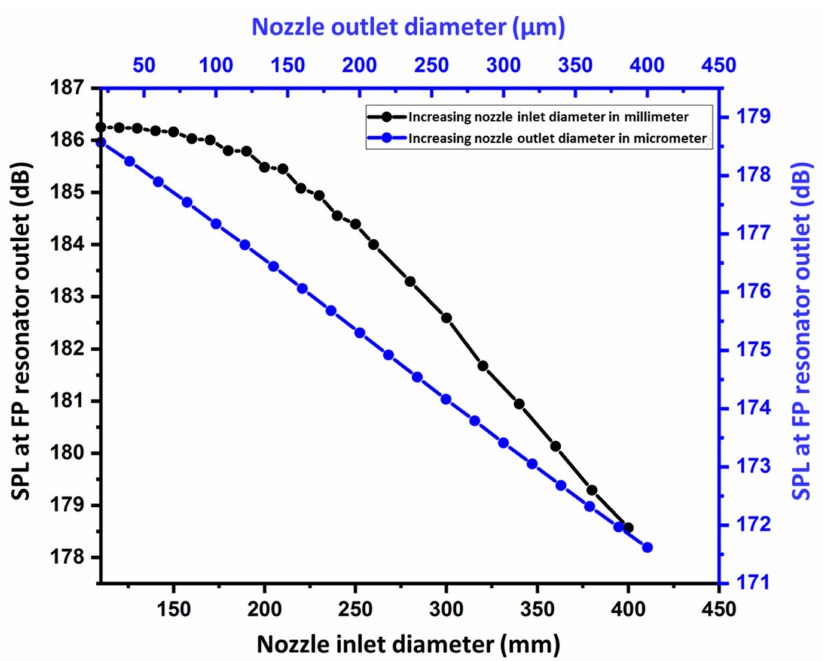
Figure 6. Effect of changing the nozzle inlet and outlet diameters on the pressure response at the FP resonator